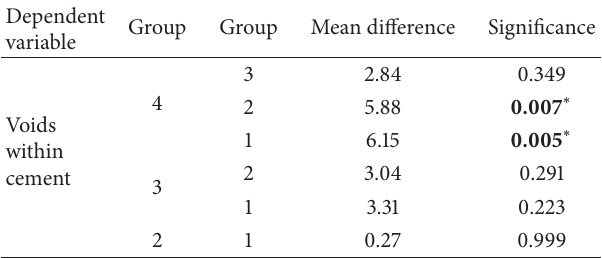
Table 4: Results of Tukey’s post hoc